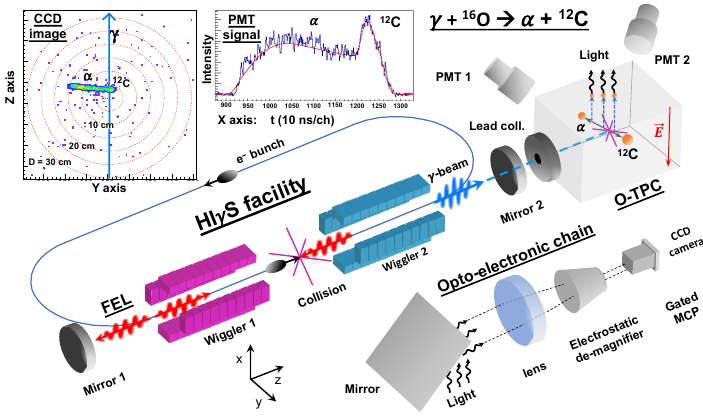
Fig. 2: A schematic diagram of the HI g S gamma-beam system, the O-TPC detector and the opto-electronic readout chain, taken from [6]. A Typical track recorded by the CCD camera and the PMT signals, are shown together with the line shape analysis of the PMT time projection